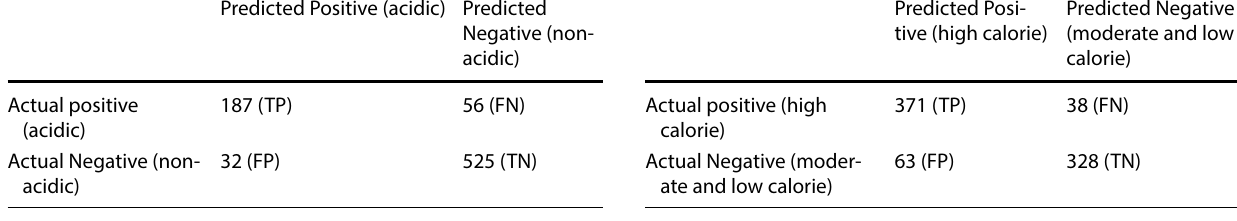
Table 4 Confusion matrix while classifying the recipes into high- Table 2 Confusion matrix while classifying the recipes into liked calorie recipes and moderate or low-calorie recipes and disliked recipes (binary classification based on taste) Predicted Positive (acidic) Predicted Predicted Posi- Predicted Negative Negative (non- tive (high calorie) (moderate and